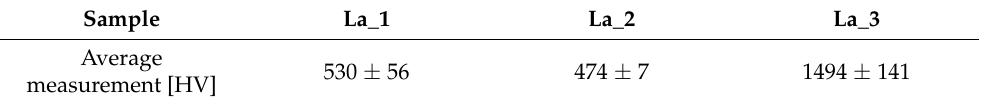
Table 8. The highest value of microhardness (1494 HV) was identified for the sample with the highest concentration of lanthanum (1 at.%) and aluminum (1